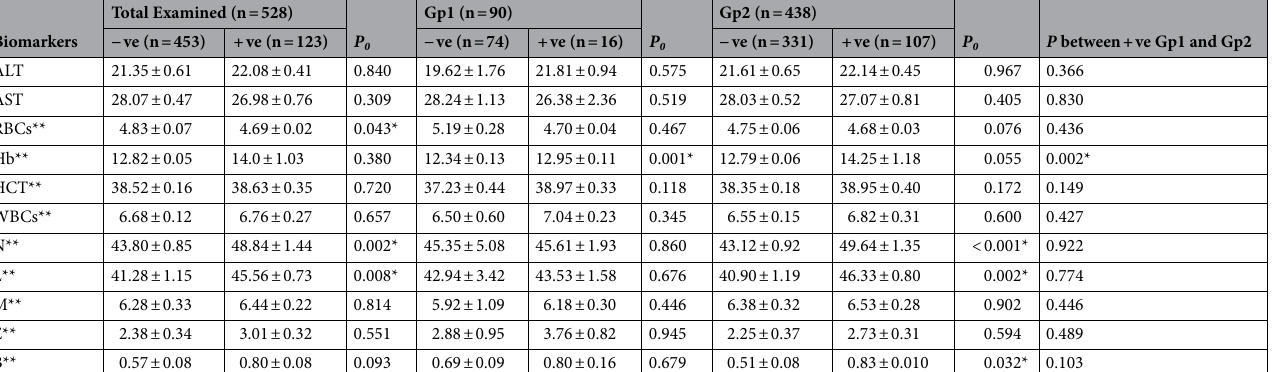
Table 7. Cryptosporidium spp. in relation to some biomarkers and their effects on swimmers’ performance. Gp group, -ve negative, + ve positive, ALT alanine transferase, AST aspartate transferase, RBCs red blood cells, test for comparing Negative and Positive. p: p-value for Mann–Whitney test for comparing Positive cases of Gp1and Gp2. *Statistically significant at p ≤ 0.05. **Sample size was